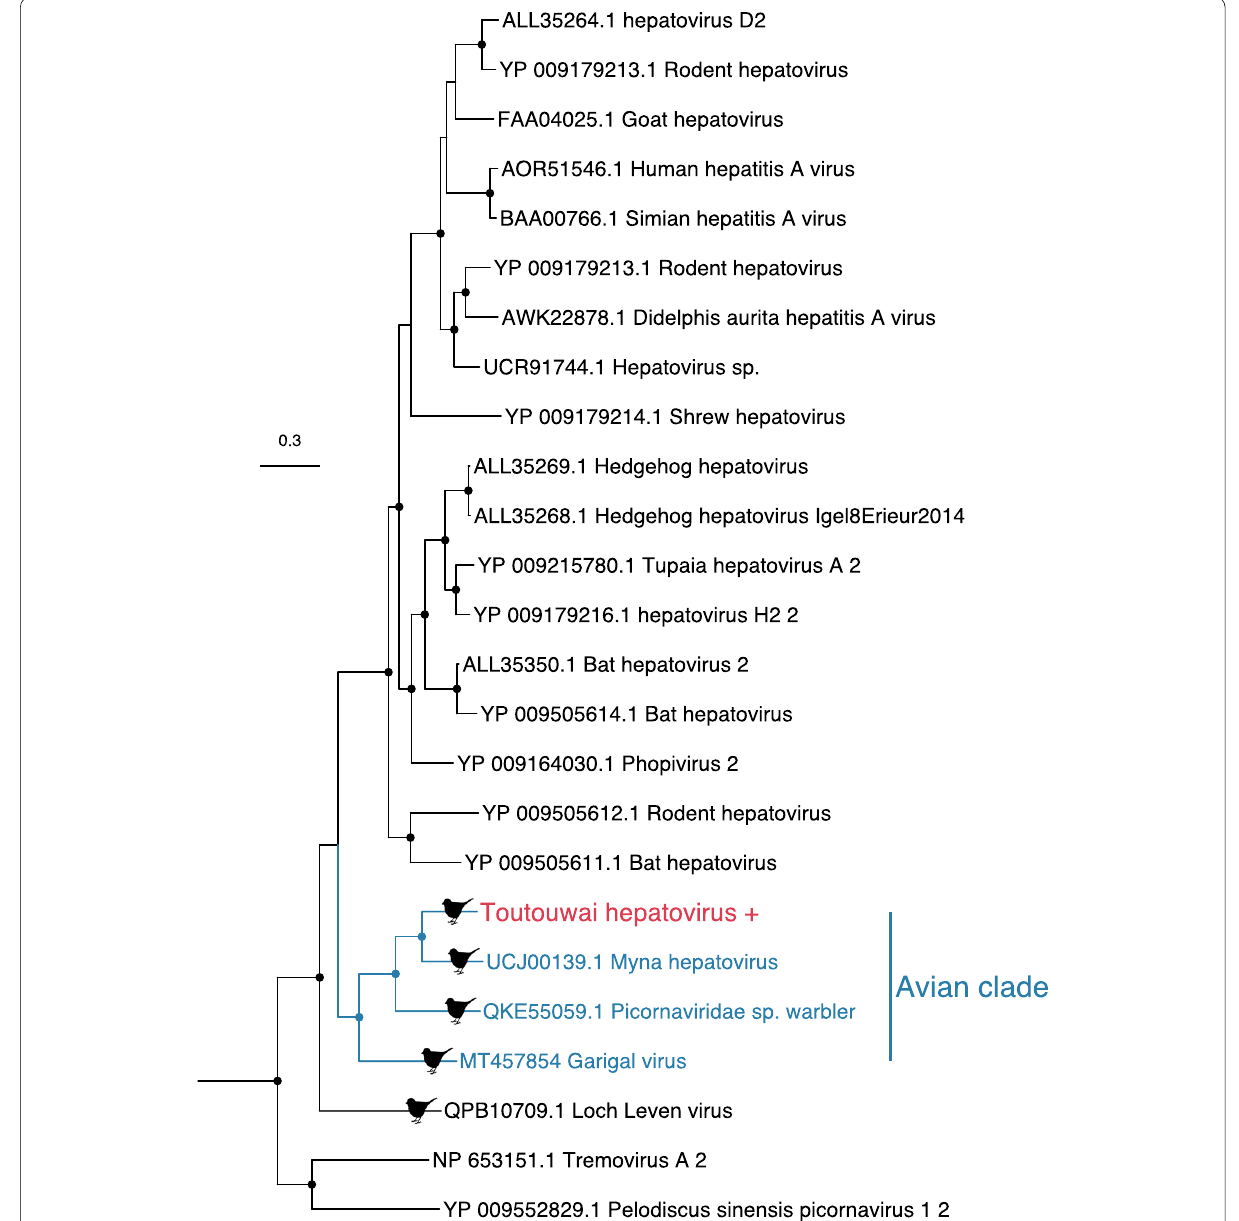
Fig. 4 Phylogeny of the genus Hepatovirus (representative viruses only) based on the RNA-dependent RNA polymerase gene (alignment length of 2201 amino acids post trimming). The virus from this study (toutouwai hepatovirus) is shown in red and has a ‘ shown by the blue tips and labels. Viruses found in birds are marked with a bird silhouette. Related viruses are shown in black. Black circles on nodes show bootstrap support values of more than 90%. Branches are scaled according to the number of amino acid substitutions per site, shown in the scale bar. The tree is midpoint rooted for purposes of clarity